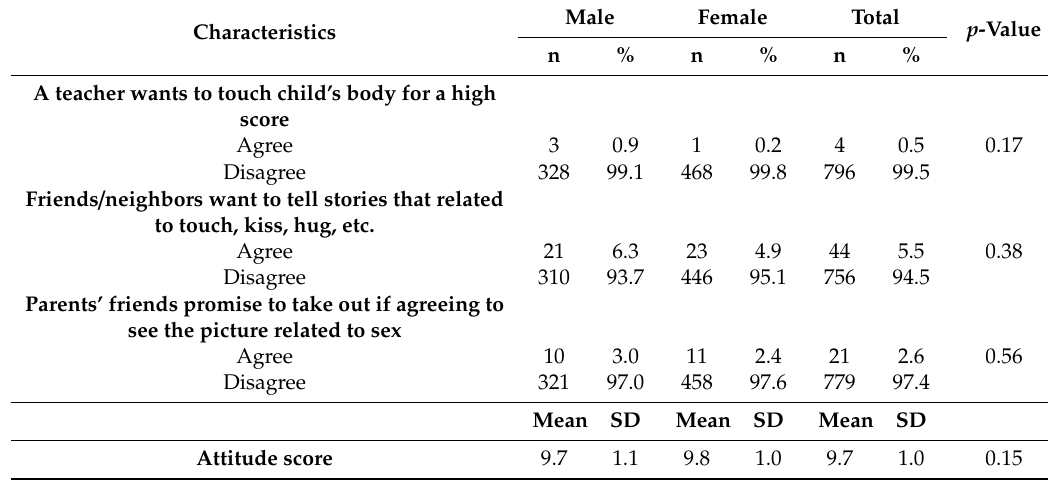
Table 3. Attitude toward child sexual abuse among school-age children. Characteristics